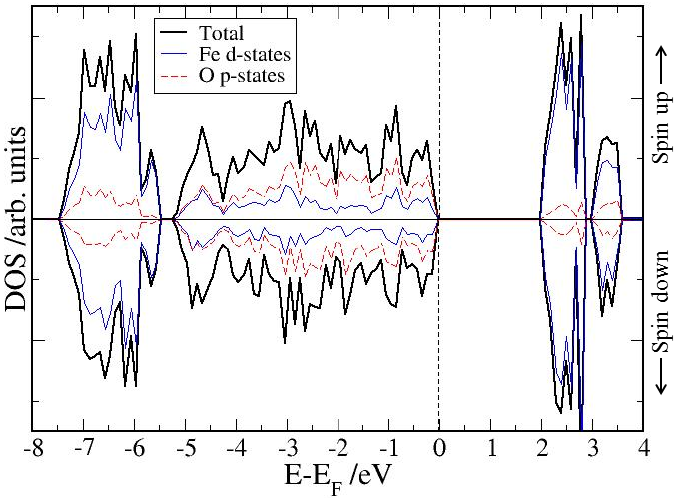
Figure 5. Density of states (DOS) of α-Fe to zero as shown by the dashed